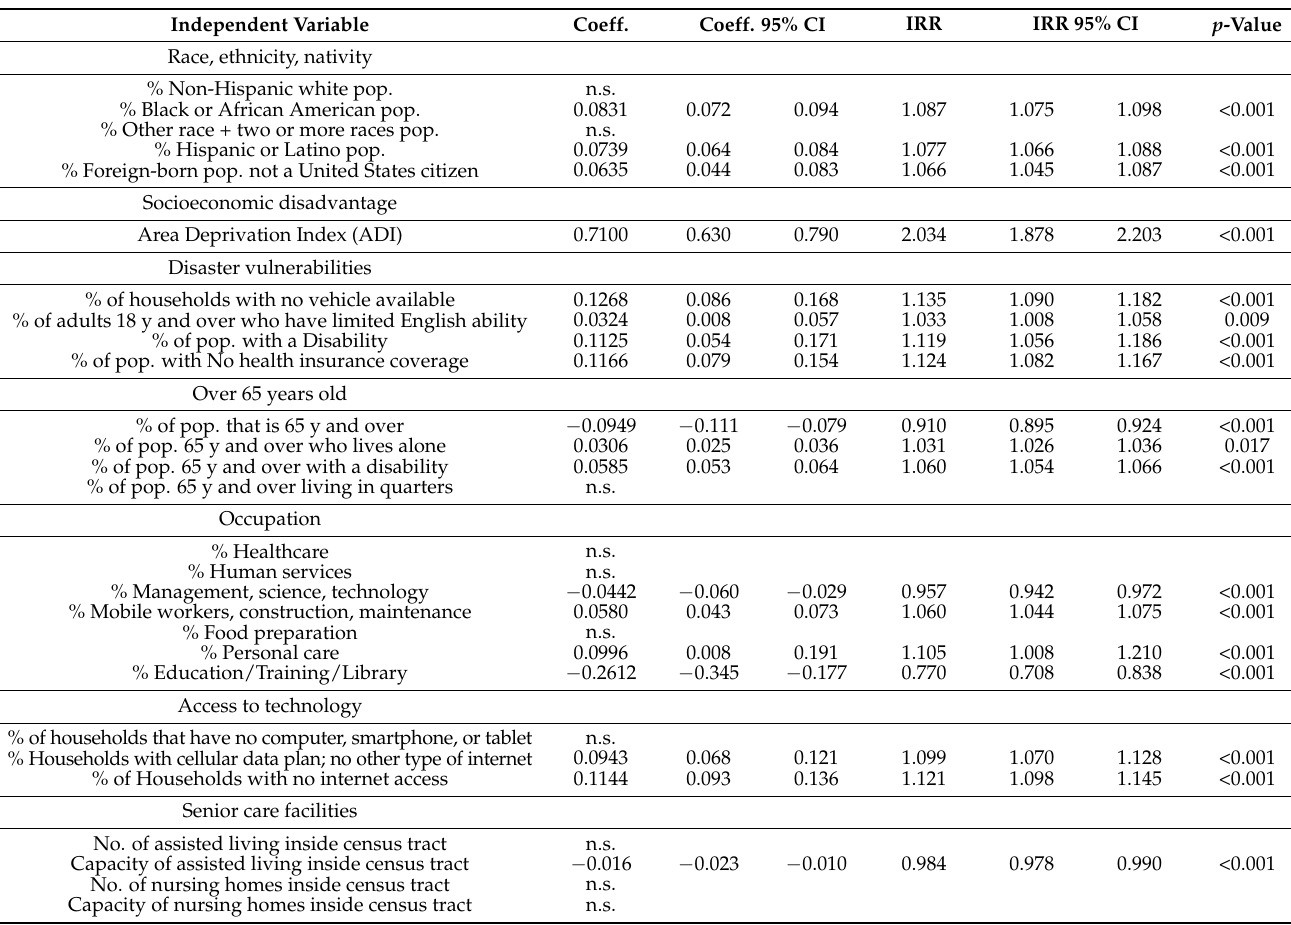
Table 3. Domain-specific multivariable relationships between neighborhood factors and the community incidence of